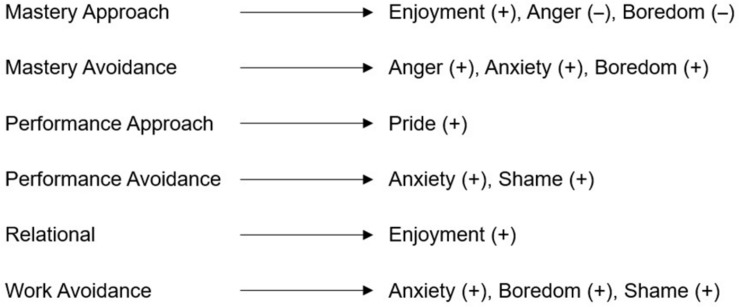
Expected direct associations between achievement goals and discrete emotions. Modified visual based on Pekrun et al. (2009).